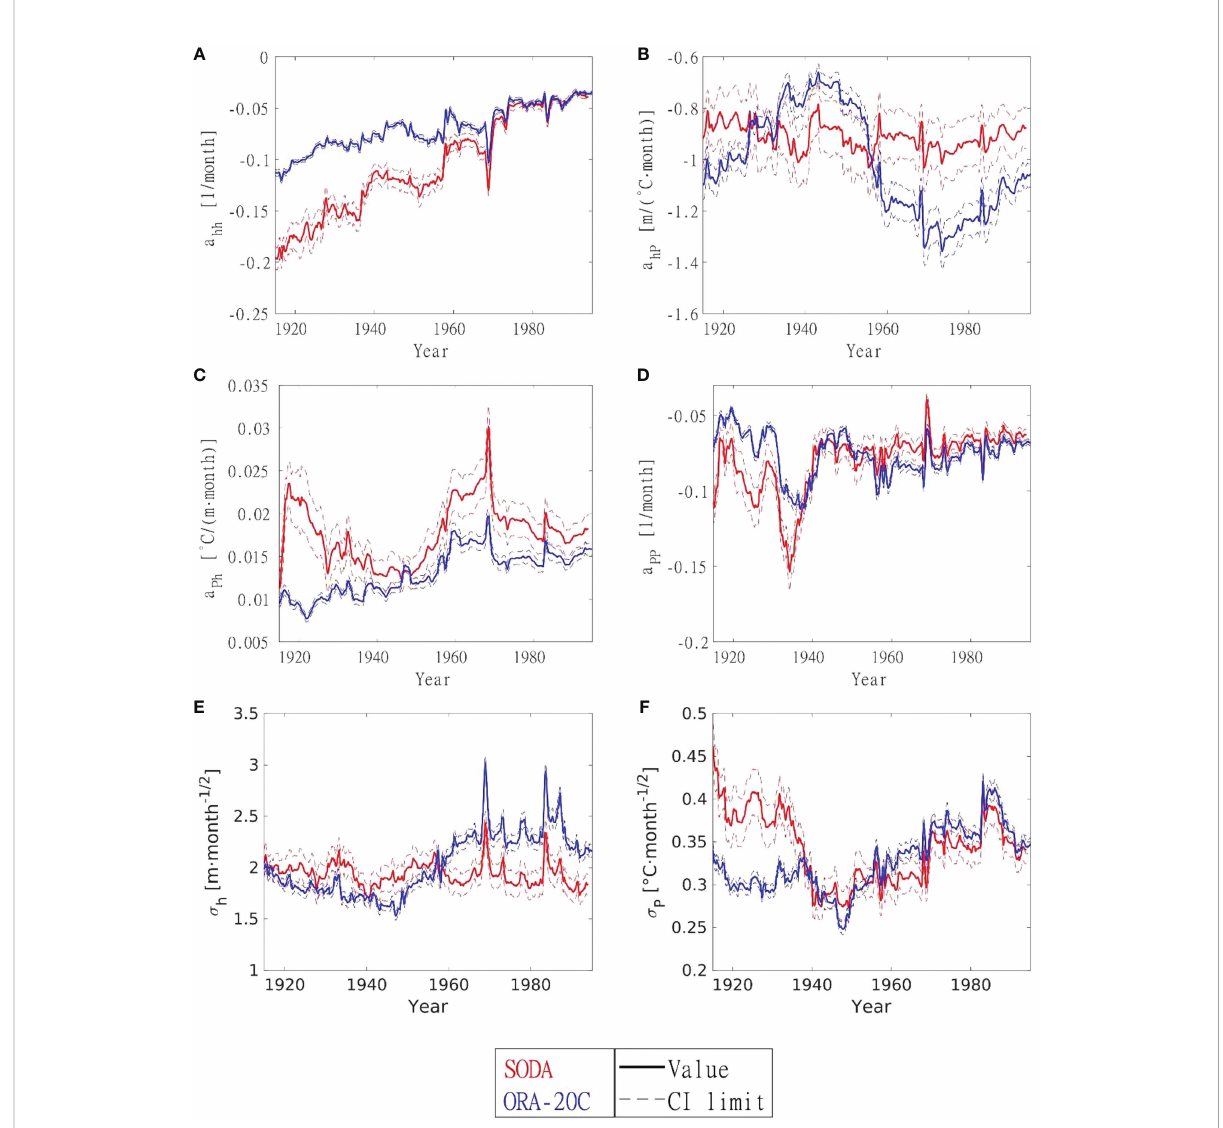
FIGURE 3 Parameter evolution computed with the ReOsc+ model for ENSO (Eq. 7 fi tted as explained in Section 2.3): Damping rates (a hh and a PP ), couplings (a hP and a Ph ) and noise amplitudes ( s h and s P ) in the period 1900-2009 for SODA (red) and ORA-20C (blue) reanalysis. (A) Damping rate of the anomalies in Paci fi c thermocline depth (a hh ). (B) Coupling of the Paci fi c thermocline depth to Paci fi c SST (a hP ). (C) Coupling of Paci fi c SST to the Paci fi c thermocline depth (a Ph ). (D) Damping rate of the anomalies in Paci fi c SST (a PP ). (E) Noise amplitude directly affecting Paci fi c thermocline depth anomalies. (F) Noise amplitude directly affecting Paci fi c SST anomalies. Each point of the fi gure considers a time window of 30 years, and the represented year in the horizontal axis is the mean value of that interval. Solid lines represent the parameter ’ s values, and dashed lines show the (1-standard-deviation) con fi dence intervals (Supplementary Appendix